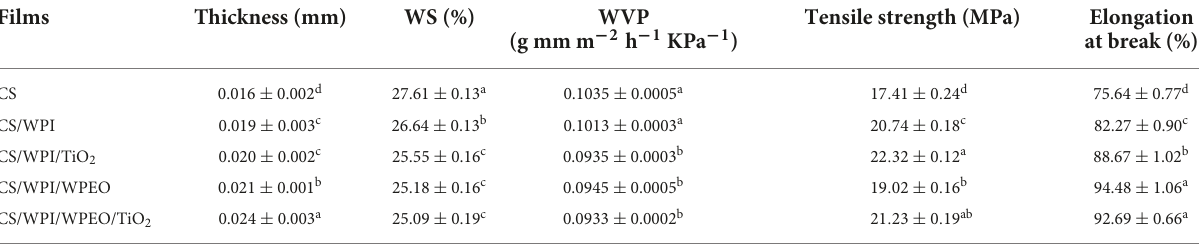
TABLE 1 The parameters of thickness, WS, WVP, TS, and Eb in prepared